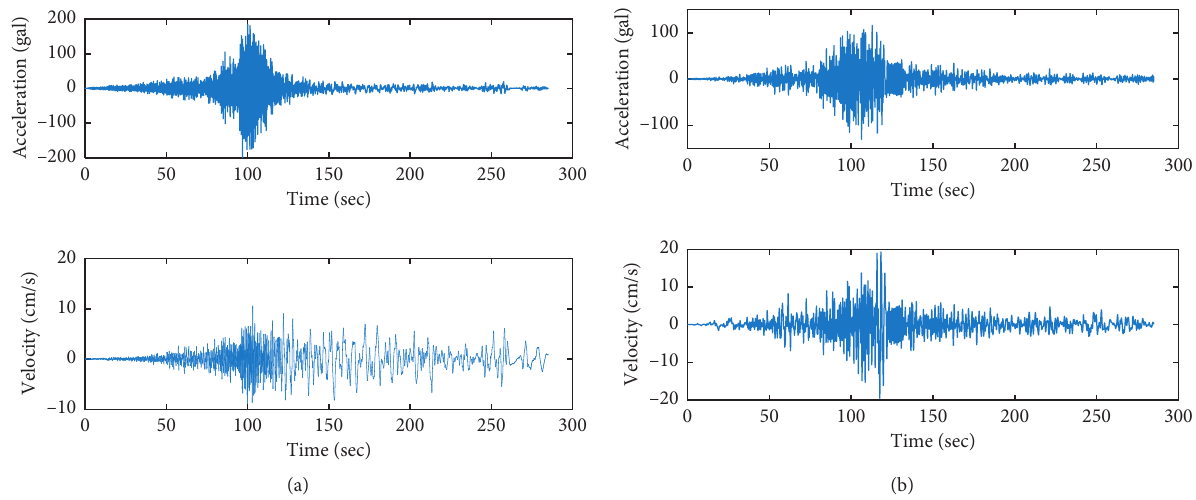
Figure 18: Simulations of acceleration and velocity time series by means of wavelet packets. (a) CHB002EW and (b)